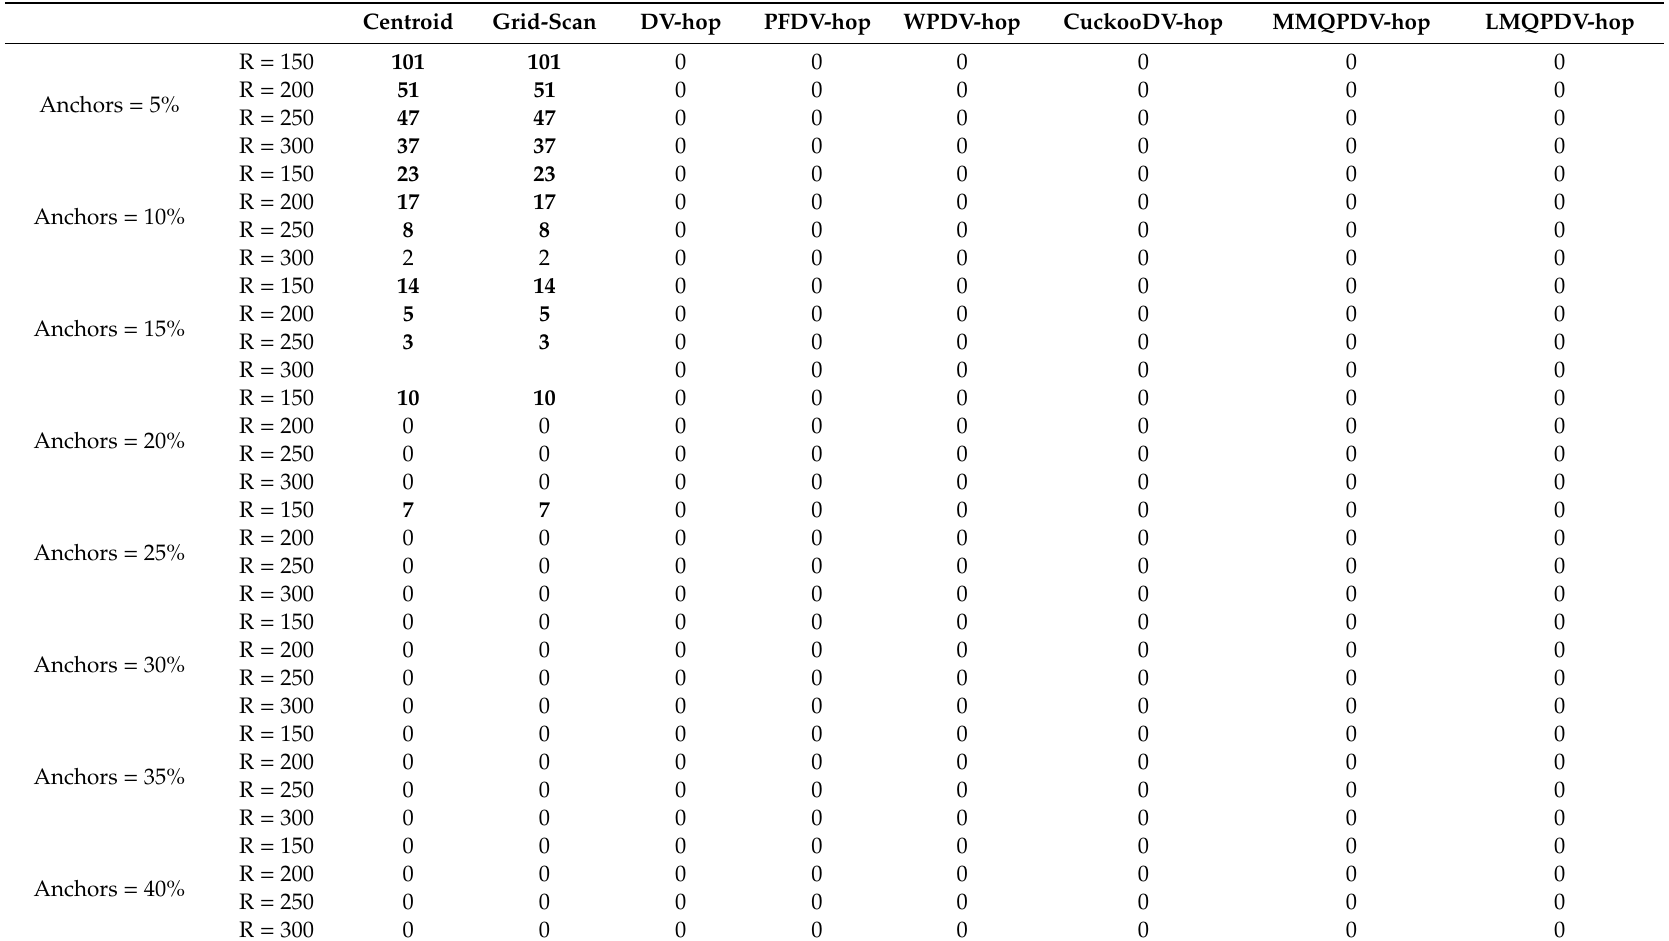
Table 4. Number of unresolved sensors for